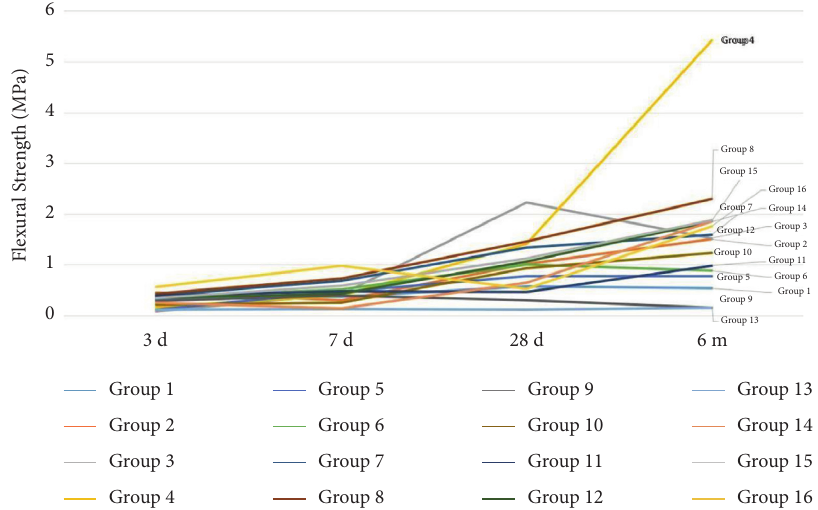
Figure 5: Change trends of the flexural strength